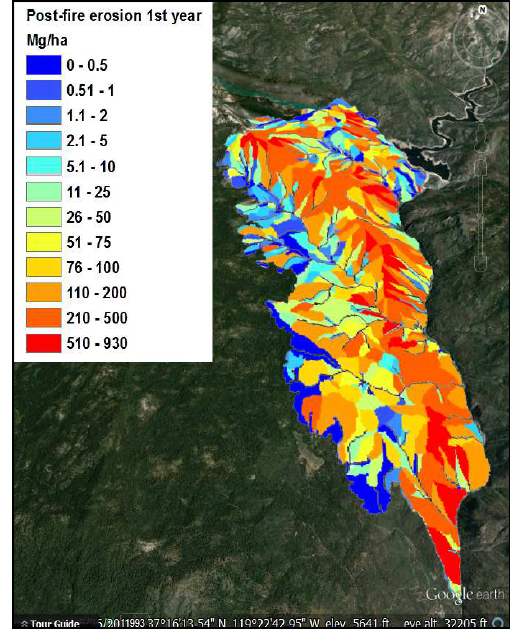
Figure 5. Post-fire hillslope erosion predictions for the French fire displayed in Google